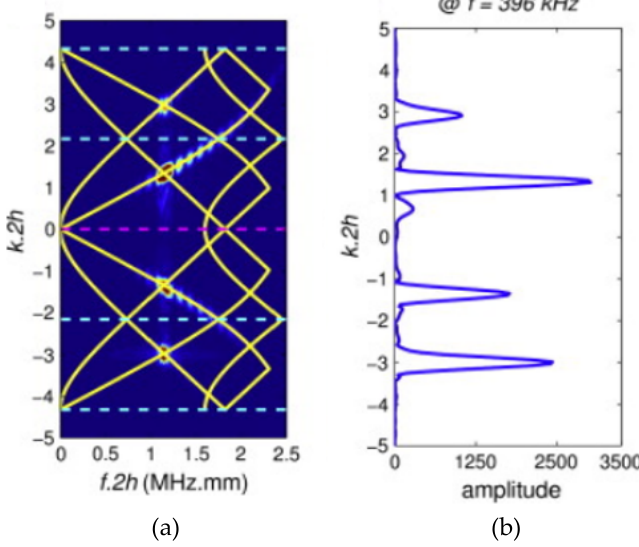
Figure 21. ( a ) Wavenumber-frequency representation of the signals measured under the grating for an excitation frequency belonging to the gap; ( b ) Amplitude versus wavenumber at a frequency f=396kHz